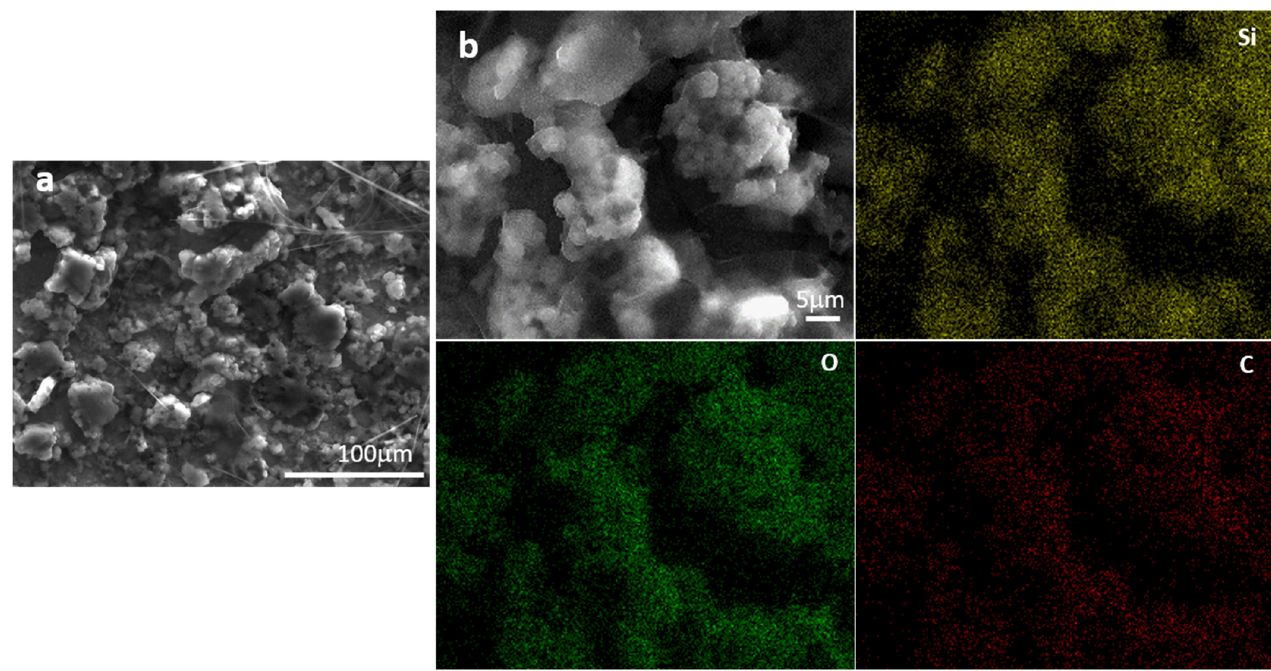
Figure 8. SEM image for the ( a ) C/SiO 2 -0.085 M calendered electrode after 200 cycles; ( b ) SEM-EDAX elemental mapping of Si, O and C of the C/SiO 2 -0.085 M calendered electrode after 200 cycles.